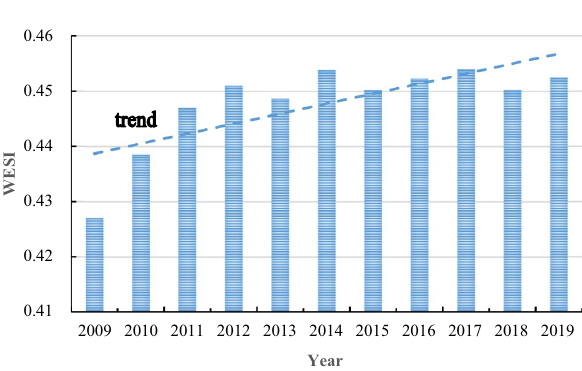
Figure 3. Trend map of water ecological security index (WESI) of nine